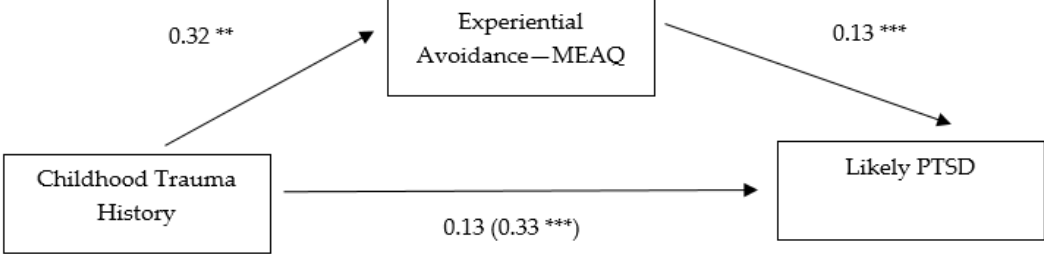
Figure 4. Indirect effect of experiential avoidance (MEAQ) on the relationship between childhood trauma history and a likely PTSD diagnosis. Note: * p < 0.05, ** p < 0.01, *** p < 0.001. Path values were drawn using unstandardized regression coefficients. Parentheses indicate the total